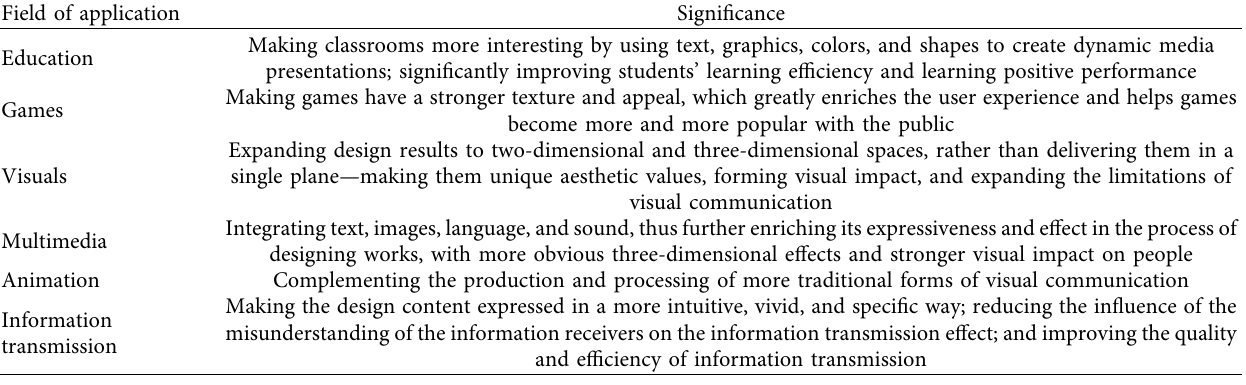
Table 2: Application of digital technology in visual communication